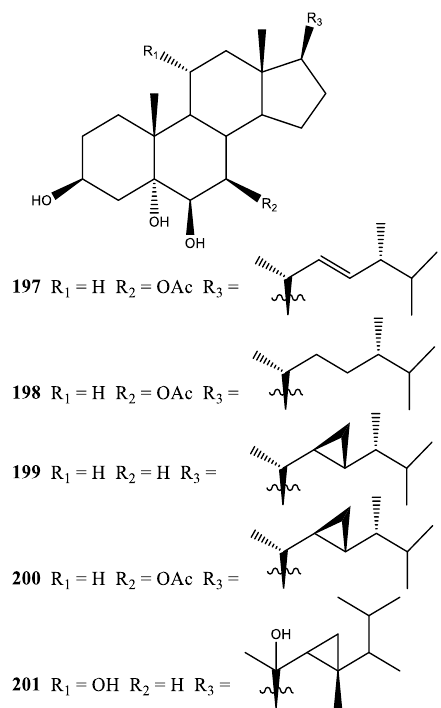
Figure 10. Structures of compounds 197 – 201